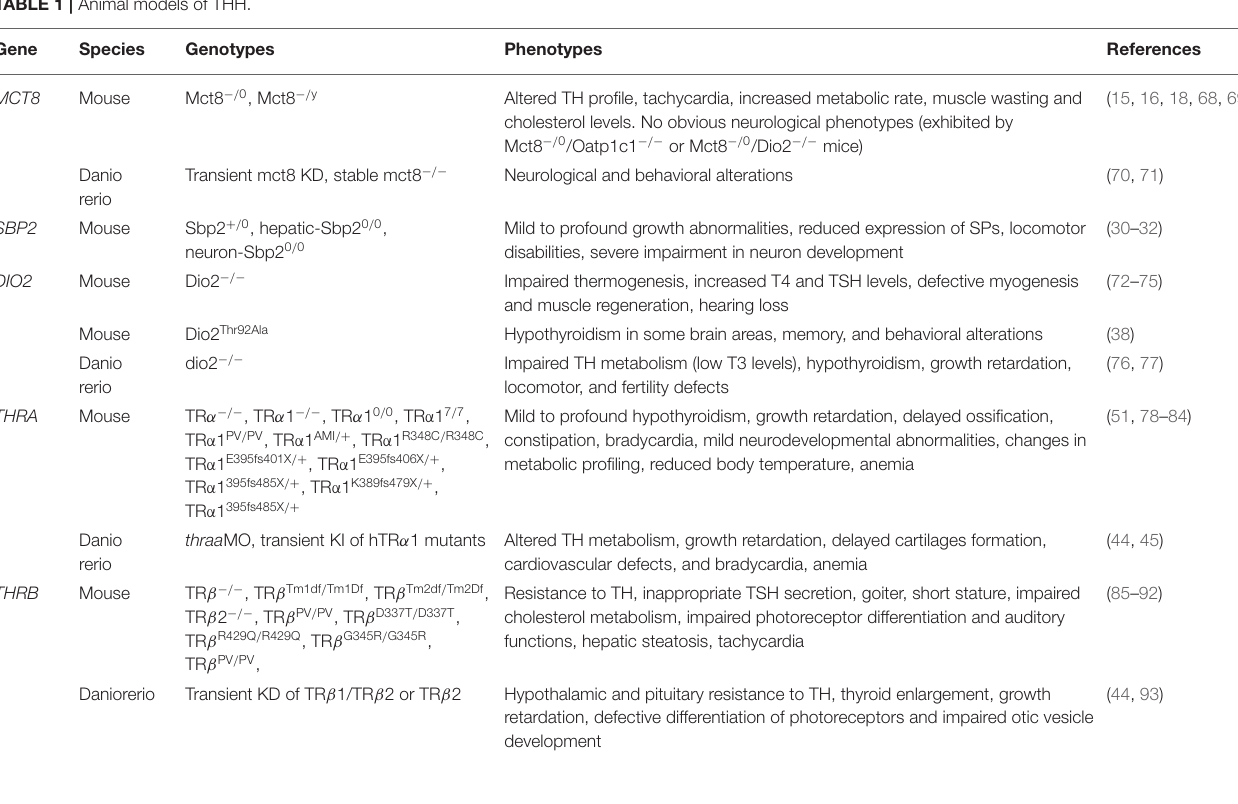
TABLE 1 | Animal models of